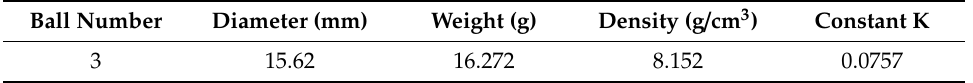
Table 7. Viscometer ball parameters.